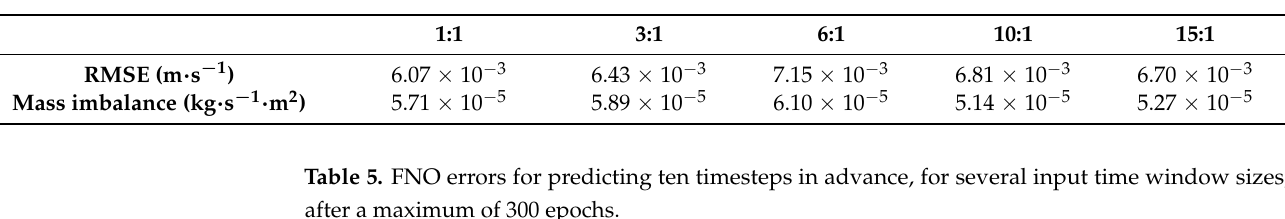
Table 4. FNO errors in predicting one timestep in advance, for several input time window sizes, after a maximum of 300 epochs.